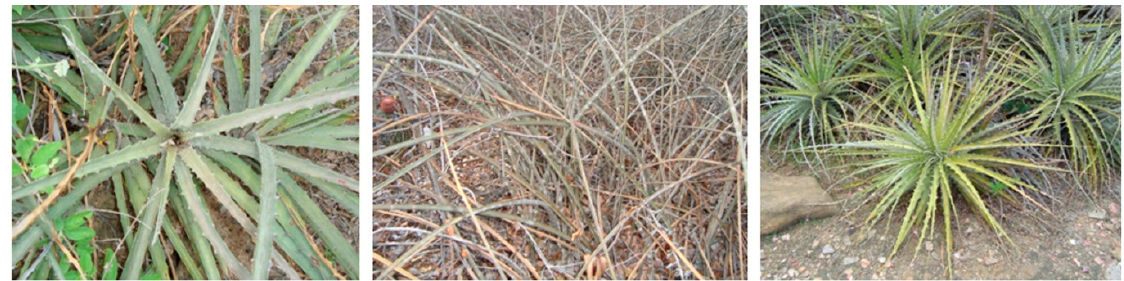
Figure 1. Bromelia laciniosa ( left ); Neoglaziovia variegata ( middle ); and Encholirium spectabile ( right ) grown in Petrolina, Pernambuco, Brazil. Photos: JRGS Almeida.